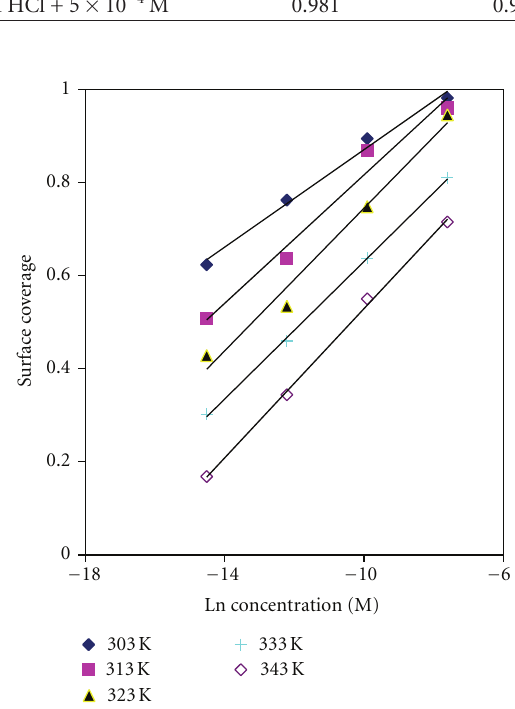
Figure 8: E ff ect of concentration of 3-benzoylmethyl benzimida- zolium hexafluoroantimonate (BMBI) on the surface coverage of mild steel in 1.0M HCl at various